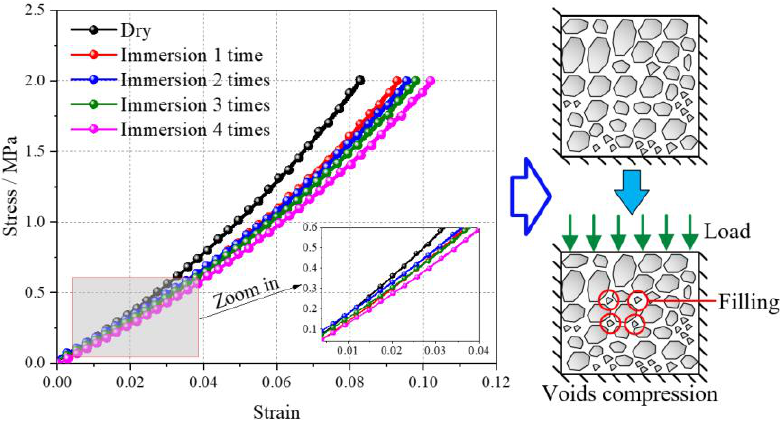
Figure 12. Stress – strain curve of the gangue with different immersion times. Figure 12. Stress–strain curve of the gangue with different immersion